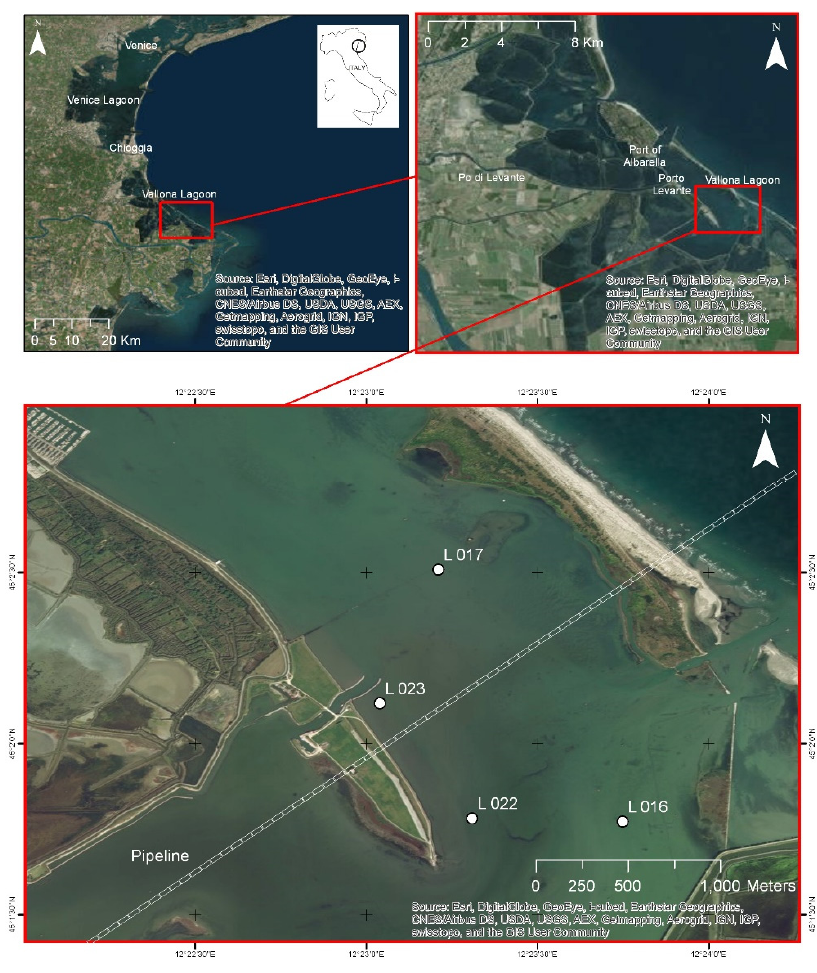
Figure 1. Maps of the Vallona lagoon (NE, Italy) with localizations of the four sampling sites of Manila clams ( R. philippinarum ).